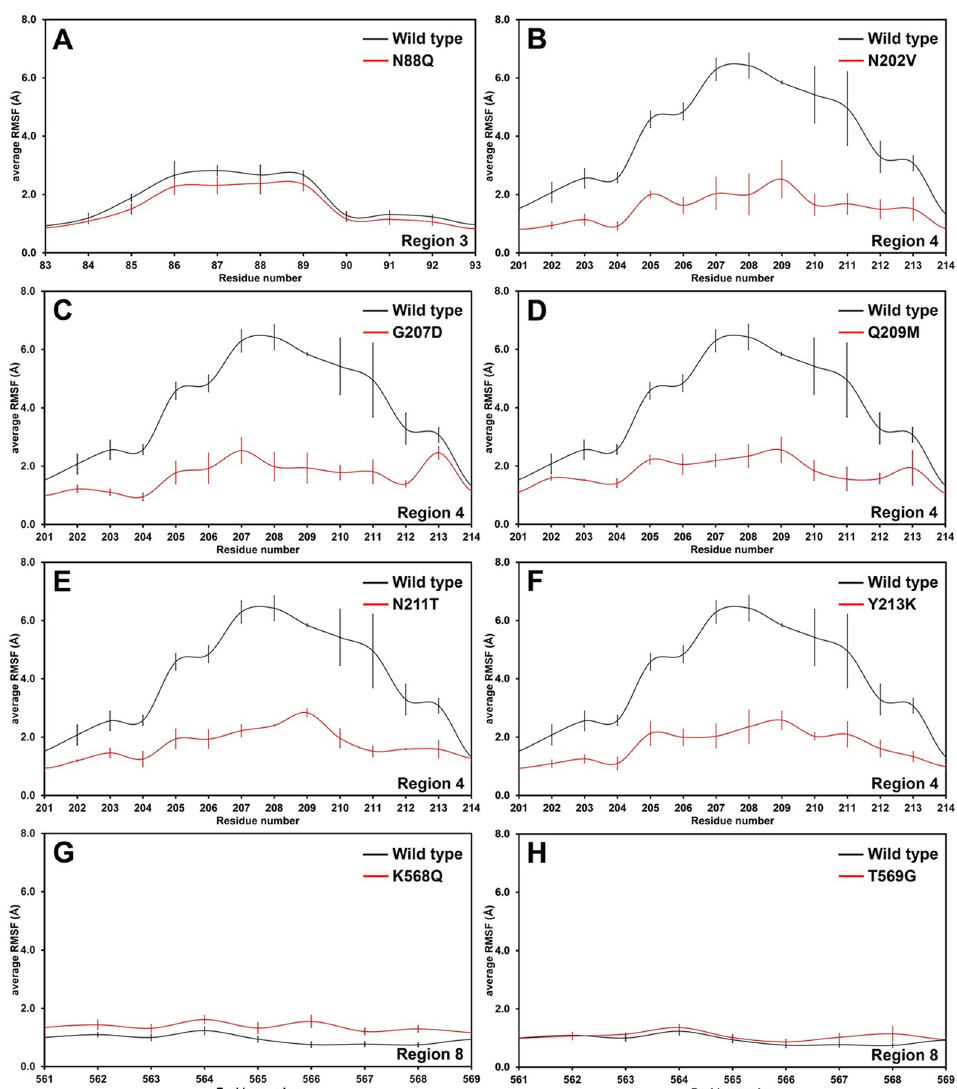
Fig 4. RMSF plots with their S.E.M. values of the designed mutants (A-H) as compared to those of the wild type after simulations at 313 K demonstrates that the flexibilities of the designed regions of N88Q, N202V, G207D, Q209M, N211T and Y213K mutants are lower than those of the wild type. Black lines are plots of the wild type, and red lines are plots of the designed